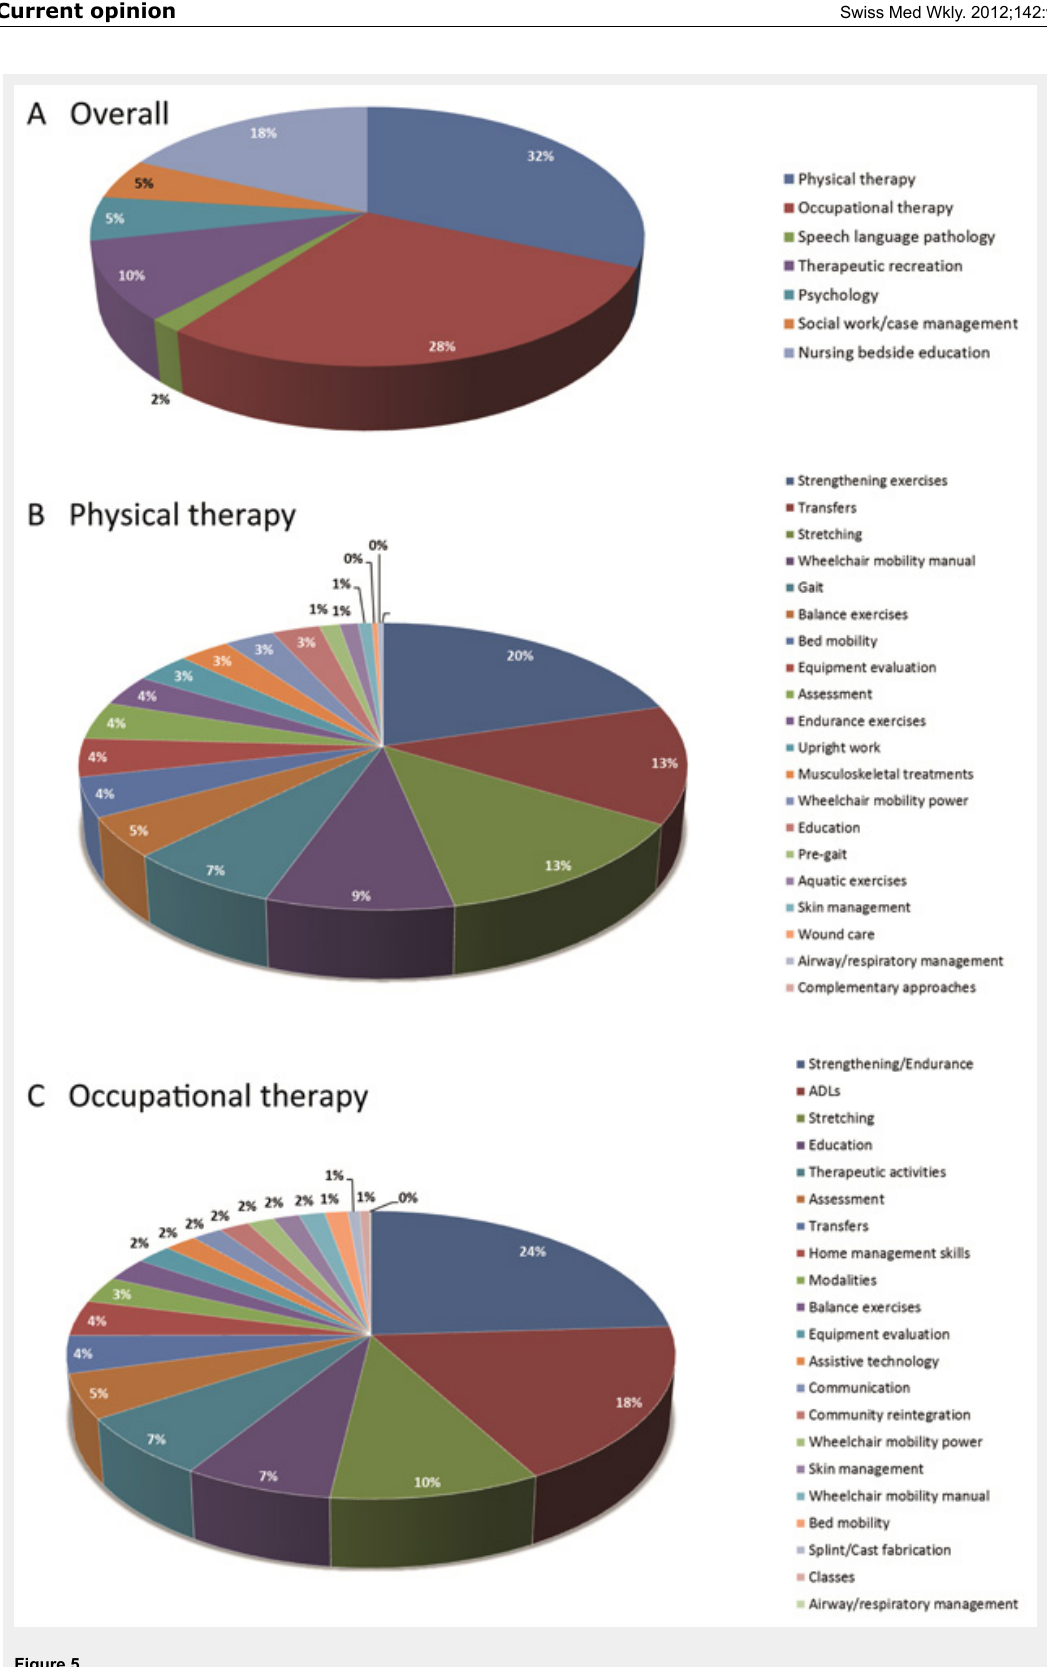
Figure 5 Percentages of time spent during rehabilitation. Numbers from the SCIRehab project showing the percentage of time of 600 patients (132 high cervical AIS A, B and C; 151 low cervical AIS A, B and C; 223 paraplegic AIS A, B and C and 94 AIS D patients) spent during rehabilitation. (A), overall distribution of the various disciplines, (B), percentages of time spent in physical therapy activities and (C) occupational therapy activities. Please note that large differences between the patient groups exist. For more details, see the original publications from the SCIRehab project [44,